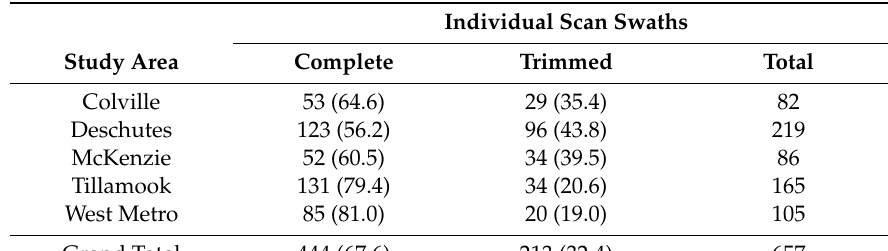
Table 3. Number of complete vs. spatially trimmed laser scan swaths in each study area. Quantities in parenthesis denote study area percentages.